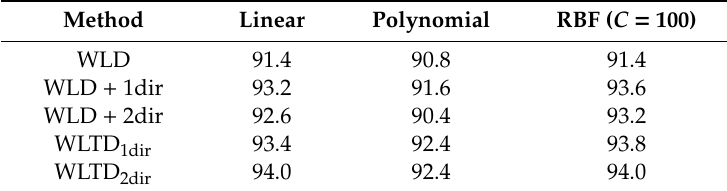
Table 1. Comparison of experimental results between WLD and WTLD of Kirsch mask.